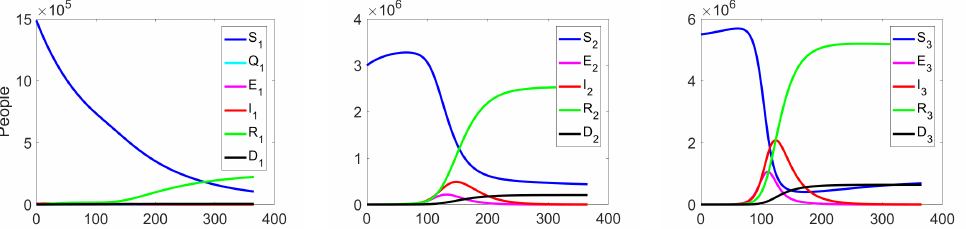
Figure 5. Experiment 1. Spread of the virus in three different clusters in an uncontrolled case.